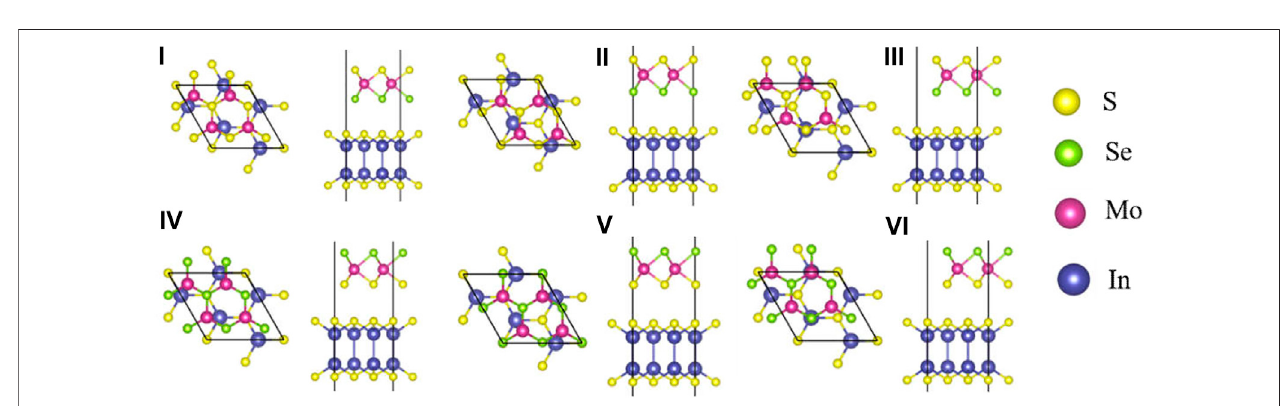
FIGURE 2 | The top and side views of six stacking patterns of the MoSSe/InS vdWHs. The yellow, green, purple and blue balls represent the S, Se, Mo and In atoms, respectively.